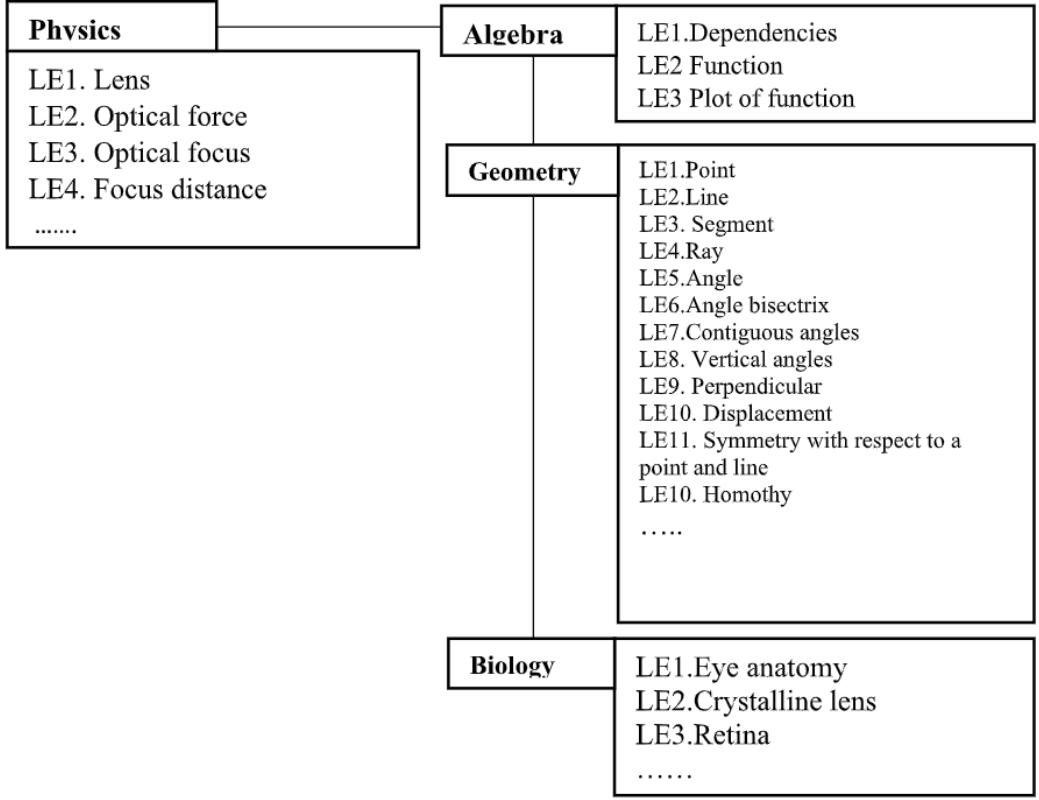
Figure 23: Presentation of paper